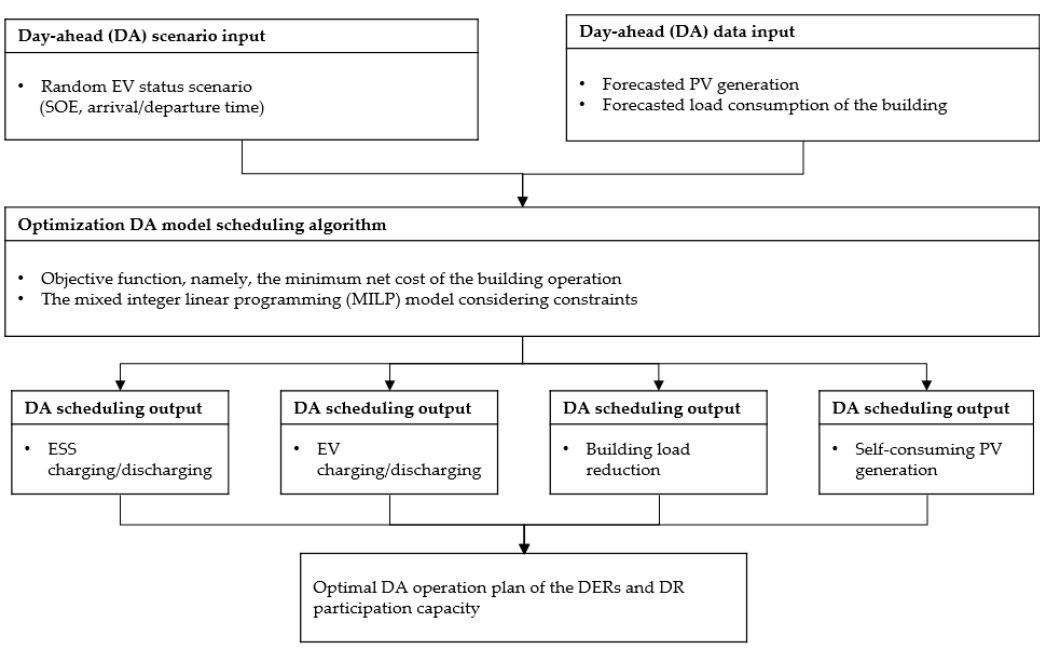
Figure 3. The structural framework of the scheduling method.